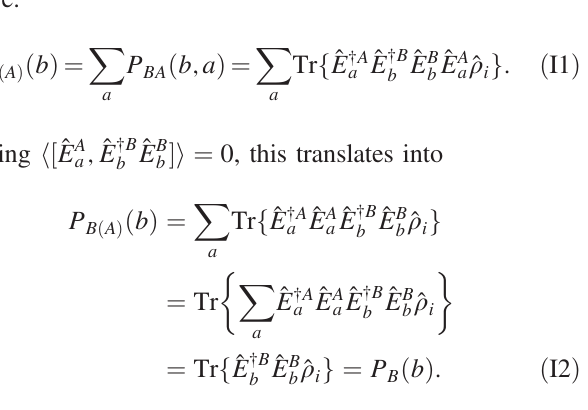
, which is calculated ð A Þ ffiffiffi ffiffiffi ffiffiffi p p p π π π , α I ¼ , α B ¼ − , ffiffiffi p π . Again, SIT is